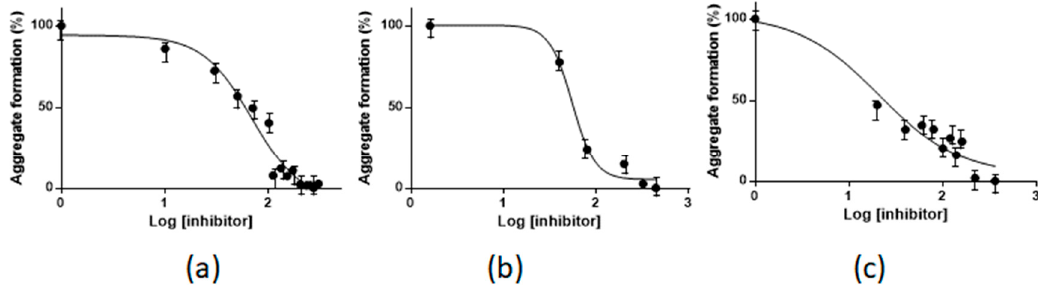
Figure 6. Inhibition of NPM1 264–277 ( a ), Sup35p 7–13 ( b ) and A β 21–40 ( c ) aggregation upon the addition of 1 , measured as a percentage variation of ThT fluorescence. IC 50 values were derived from non-linear regression fit of the data ( r 2 ≥ 0.98) by fixing the maximum and minimum values at 100 and 0%, respectively, and allowing the Hill slope to vary. Results are representative of two independent experiments. Table 2. Aggregation kinetics ( t ½ ) and maximum fluorescence intensities of NPM1 264–277 following ThT emission at indicated peptide:Pt compounds molar ratios.